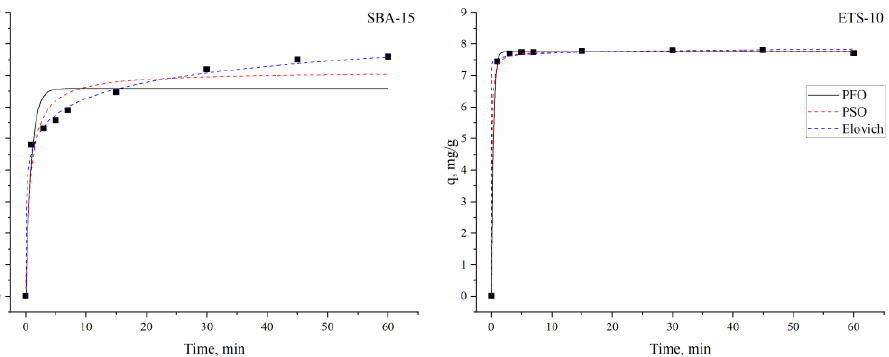
Figure 5. The kinetic models describing indium ion sorption on silica SBA-15 and titanosilicate ETS-10